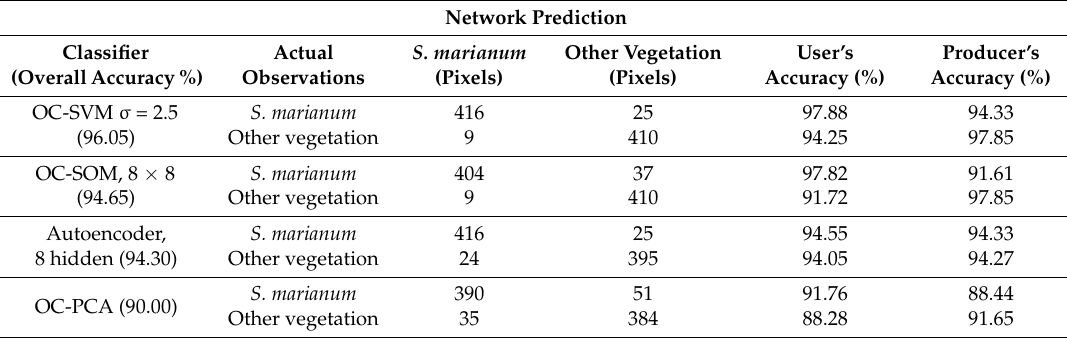
Table 1. Contingency table and optimal parameters of each classifier tested for the identification of S. marianum against other